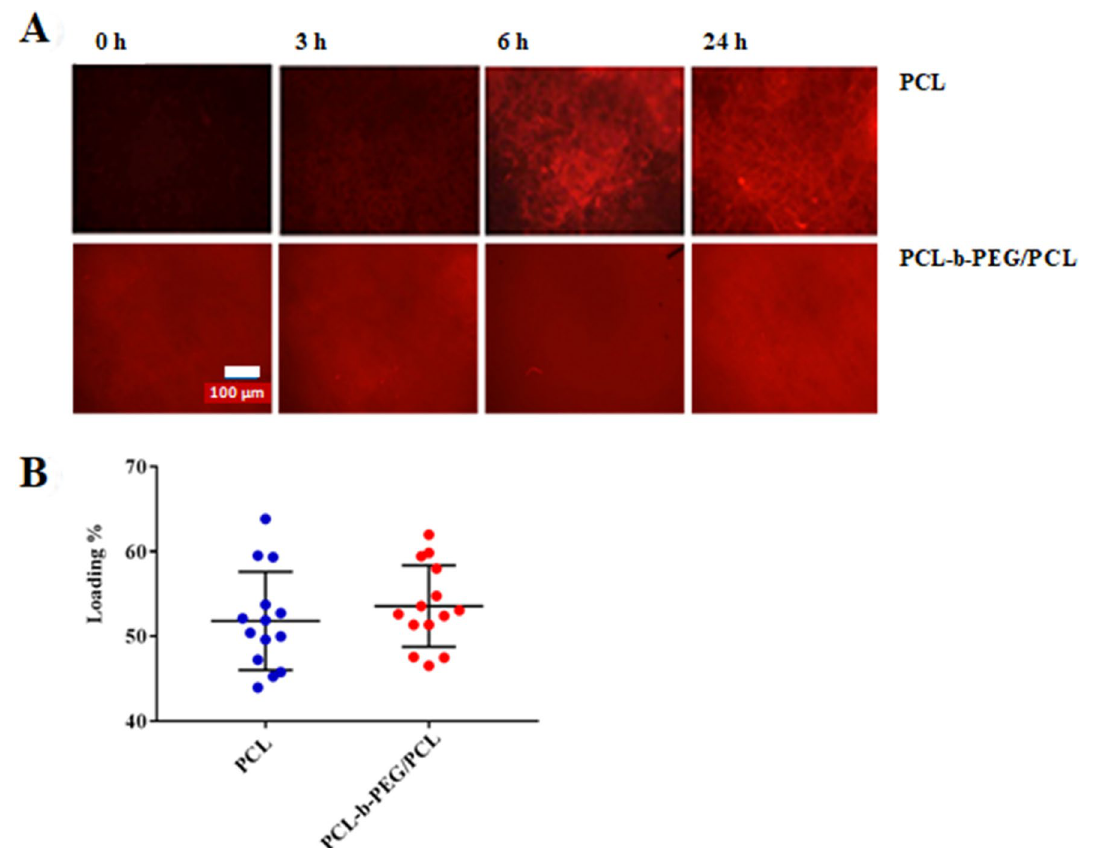
exposure. Magnification ×10, scale bar 100 microns. B L. sericata maggot E/S loading on PCL and PCL-b-PEG/PCL scaffolds. Three independent experiments carried out in triplicate (means ±